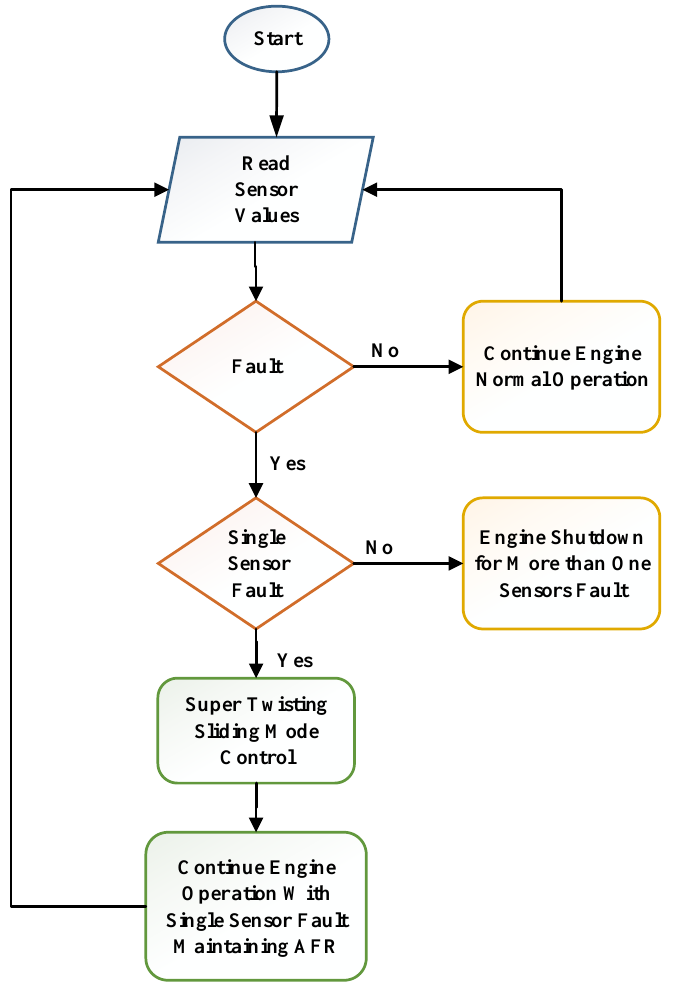
Figure 6. Flowchart of the proposed PFTCS.